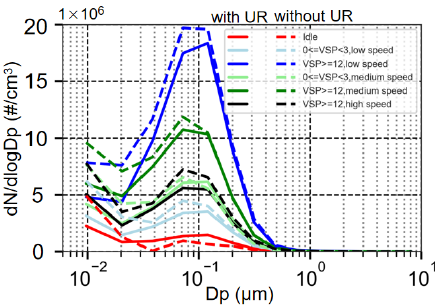
Figure 5. Variations in the PN size distribution under different VSP and speed bins both with and without the illegal application of urea regulator. without the illegal application of urea